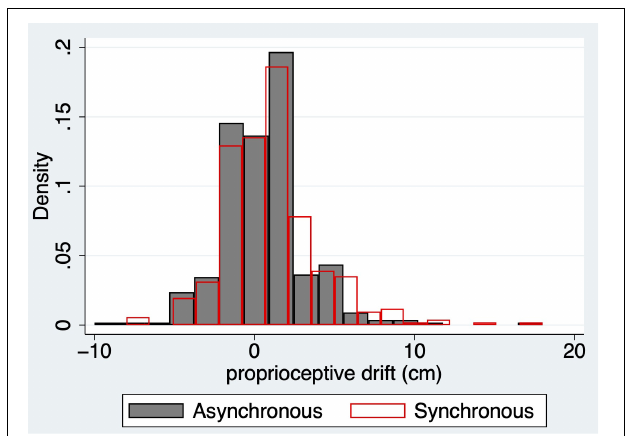
FIGURE 4 | Histograms of proprioceptive drift for the asynchronous ( dpdasync, grey solid) and synchronous responses ( dpdsync, red outline) for the full sample ( n = 353). The probability density is shown on the y-axis of the change in reported right hand location in cm towards the location of the rubber hand